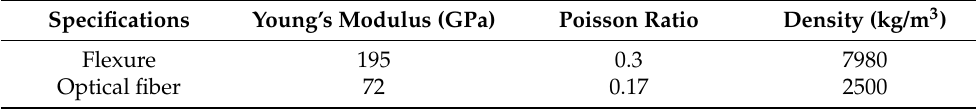
Table 2. Detailed parameters of the components of the sensor